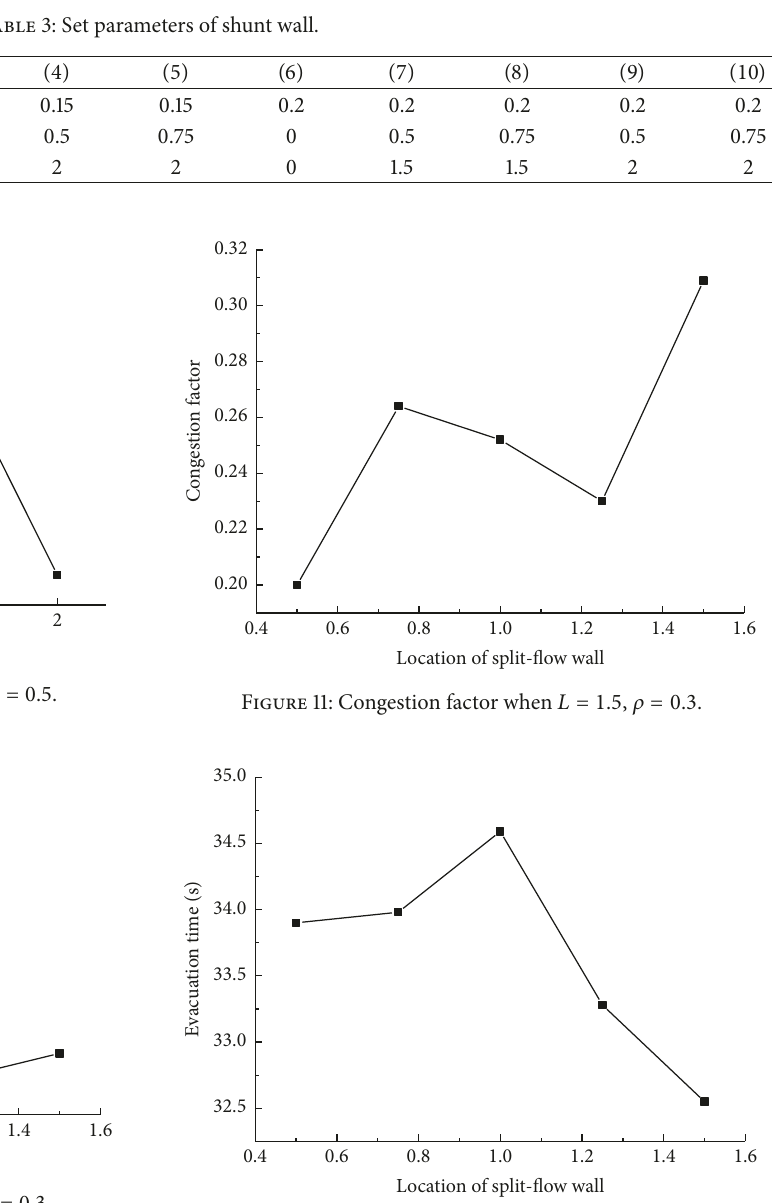
shunt wall are 3 s and 2 s when the crowd density is 0.15 p/m 2 and 2 p/m 2 ,